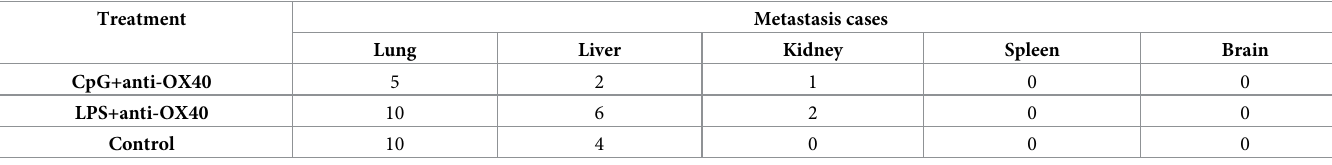
Table 2. Histopathological